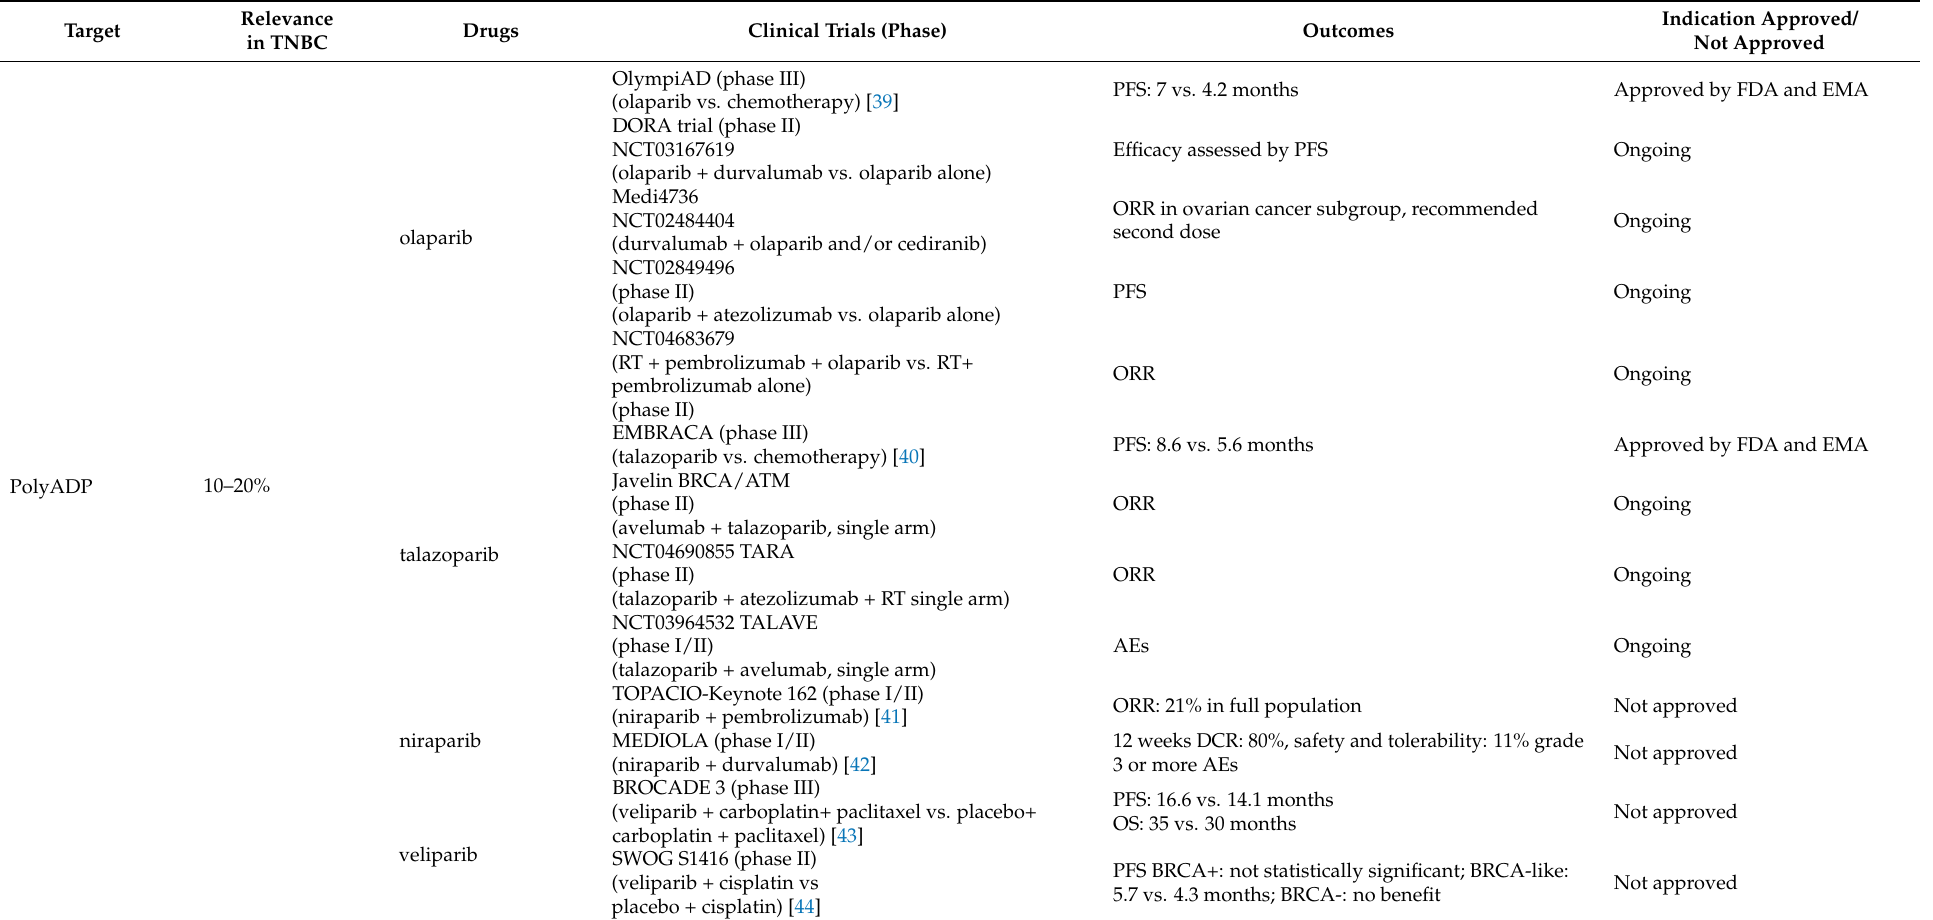
Table 2. Intracellular pathways: summary of clinical